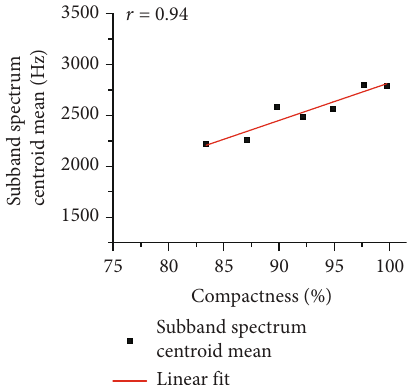
Figure 19: Correlation diagram of the mean value of the centroid of the subband spectrum and the soil mass with di ff erent compaction degrees under the action of 75(L) N hammering force.